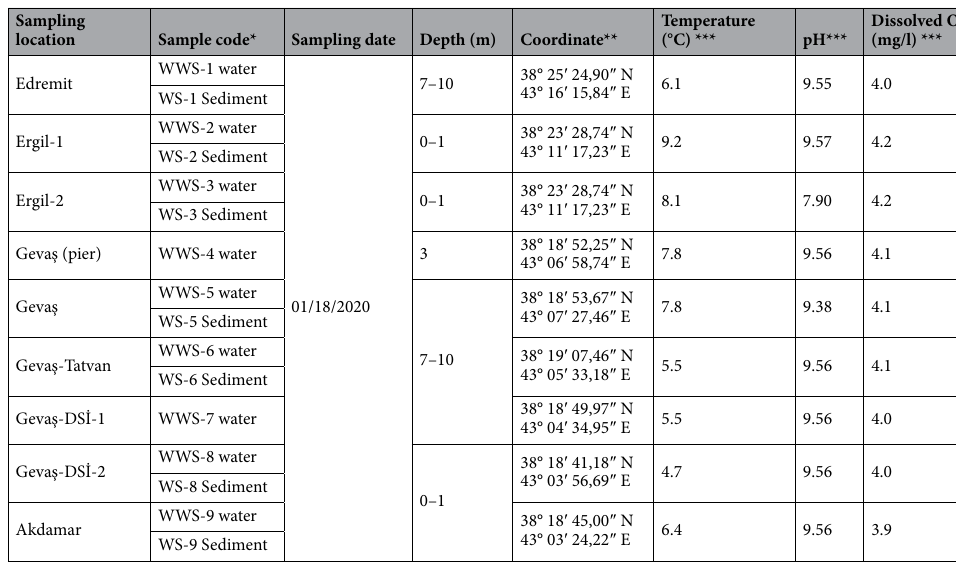
Table 2. Physicochemical parameters of lake water and sediment samples. *WWS: Water sample, WS: Sediment sample collected from Lake Van. **iGPS was used. ***HQ40d multi LDO101 and HQ40d multi PHC101 were